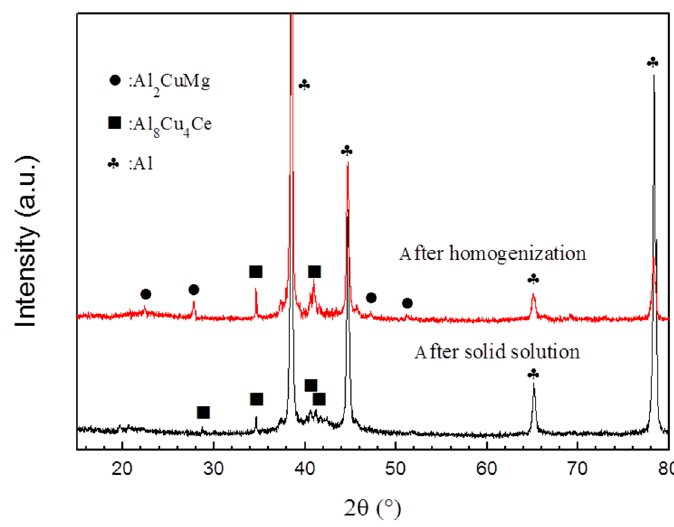
Figure 2. XRD analysis of the Ce-containing alloy after homogenization and solid solution.